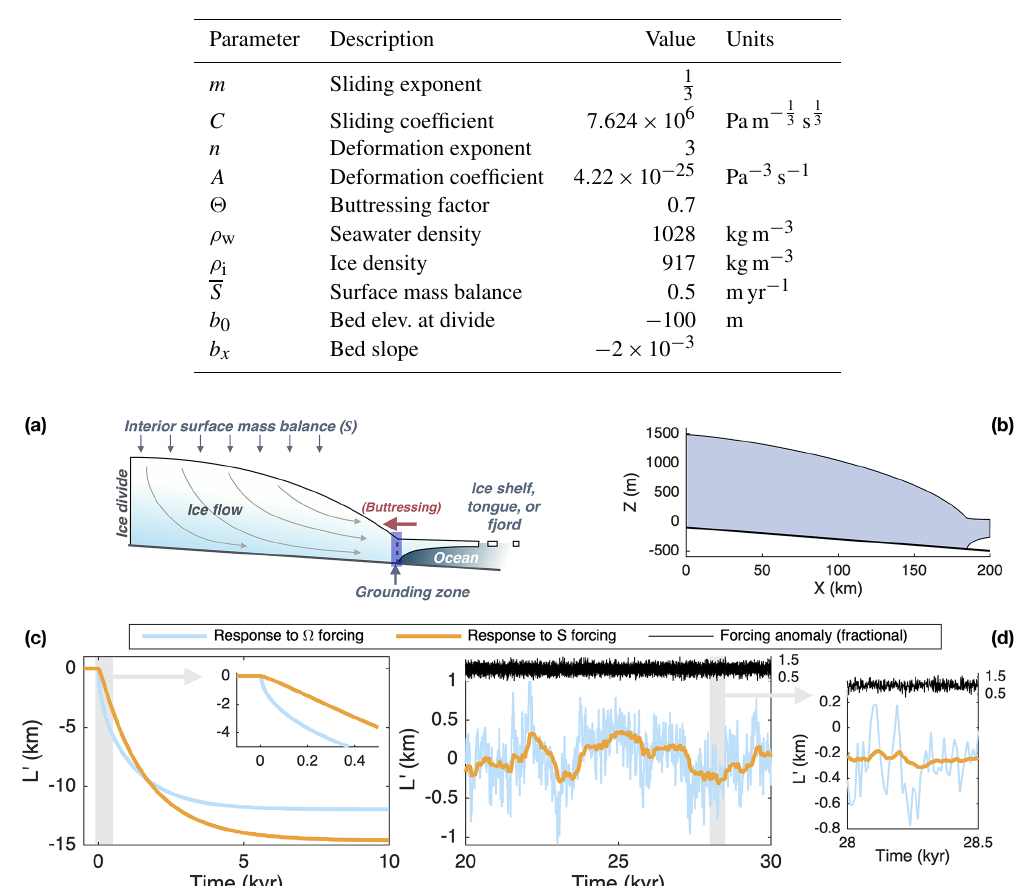
Table 1. Parameters used for flowline and two-stage models. Values for A and C follow previous idealized case studies (Schoof, 2007a; Robel et al., 2018).